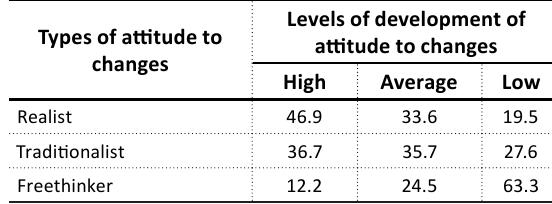
Table 2. The levels of development of types